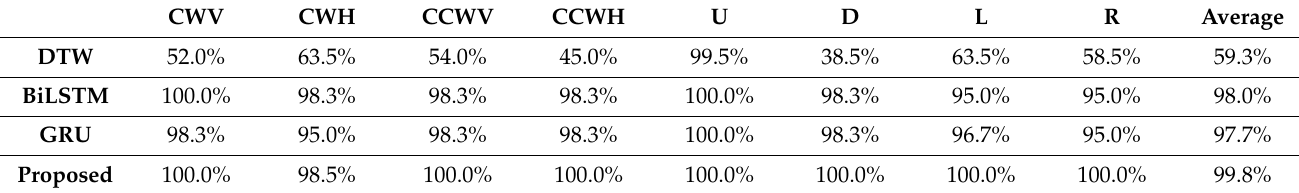
Table 6. Recognition accuracy of four HGR algorithms for each gesture.